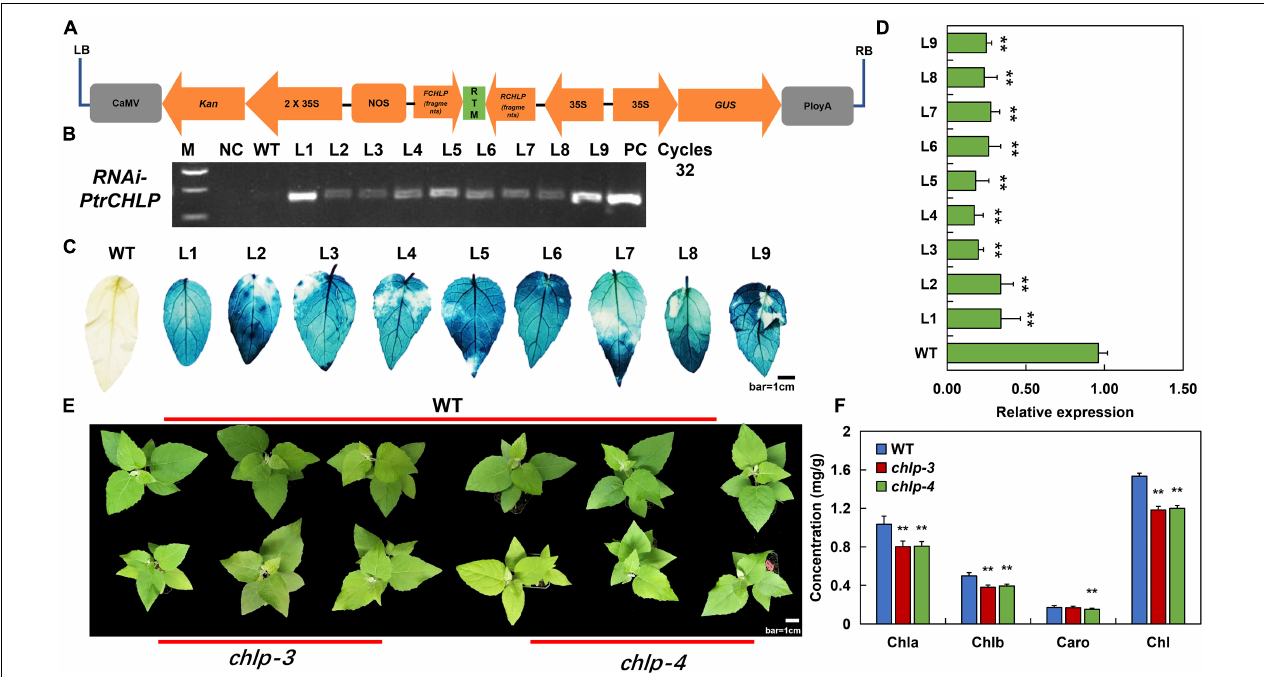
FIGURE 4 | Analysis of the transgenic poplar plants suppressing PtrCHLP3 . (A) Diagrammatic drawing of pCAMBIA2301- PtrCHLP3 –RNAi vector. Expression of dsRNA-PtrCHLP3 is activated by the double 35S promoter. (B) PCR analysis of transgenic poplar: M, DNA molecular weight marker; PC, p2301- PtrCHLP –RNAi positive control vector; WT, wild-type; NC, negative control; L1-9, PCR products with genomic DNA from regenerated kanamycin-resistant poplar 84 K leaves as a template. (C) Histochemical GUS staining of different transgenic lines. Bar = 1 cm. (D) RT-qPCR analysis of PtrCHLP3 expression levels in different transgenic lines ( chlp1–9 ). The phenotype (E) and chlorophyll content (F) of WT and PtrCHLP3 –RNAi lines ( chlp3 and chlp4 ). Bar = 1 cm. The value represents the mean ± standard deviation ( n = 20). Asterisks indicate a significant difference at the same level: ** indicates P < 0.01.